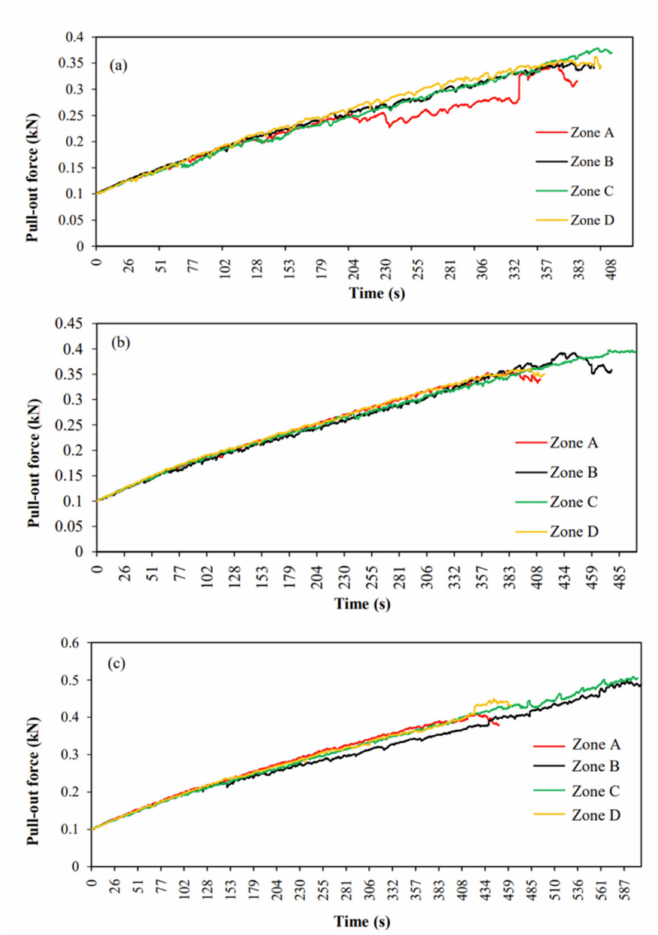
Figure 13. Variation in the pull-out force over time for the three amplitudes and three frequencies: ( a ) 0.67, ( b ) 1.29, and ( c ) 1.80